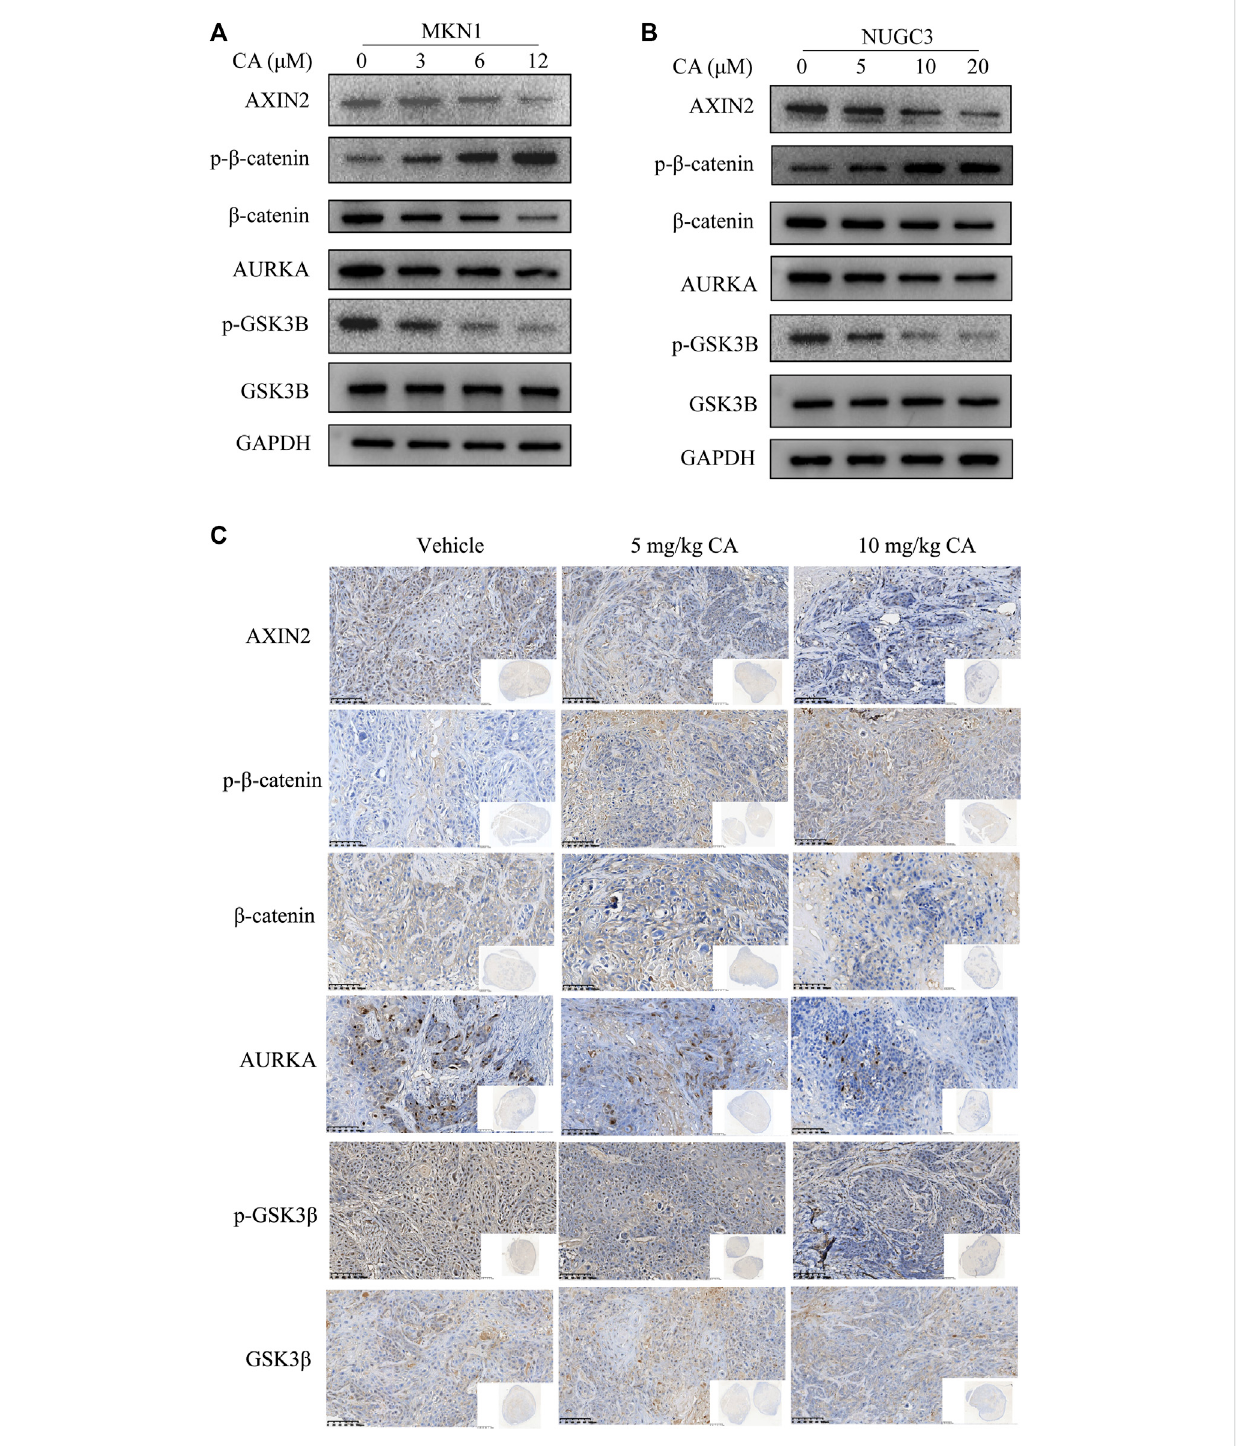
FIGURE 6 CAinhibitstheAURKA/ β -catenin/Wntpathway invitro and invivo . (A) WesternblottinganalysisoftheindicatedproteinsinMKN1cellstreatedwithdifferent concentrationsofCA for48 h. (B) WesternblottinganalysisoftheindicatedproteinsinNUGC3cellstreatedwithdifferentconcentrationsofCAfor48 h (C) IHC images of the indicated proteins in randomly selected MKN1 xenograft tumor sections after 30 days of treatment with different dosages of CA ( ×